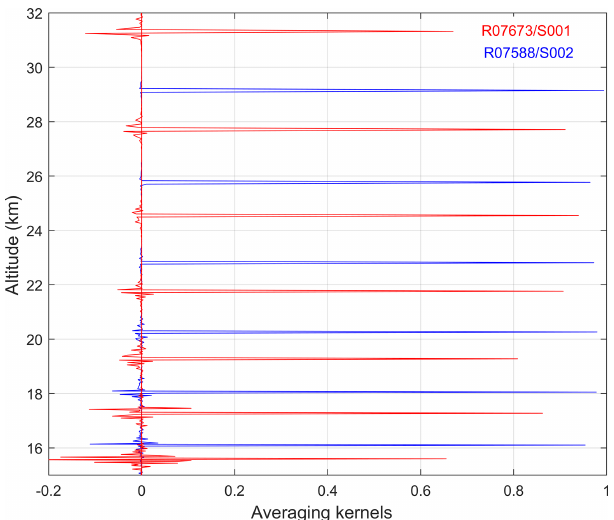
Figure 6. Examples of averaging kernels at selected altitudes, red: oblique occultation R07673/S001, blue: vertical occultation R07588/S002. The detailed information about these occultations can be found in the caption of Fig.